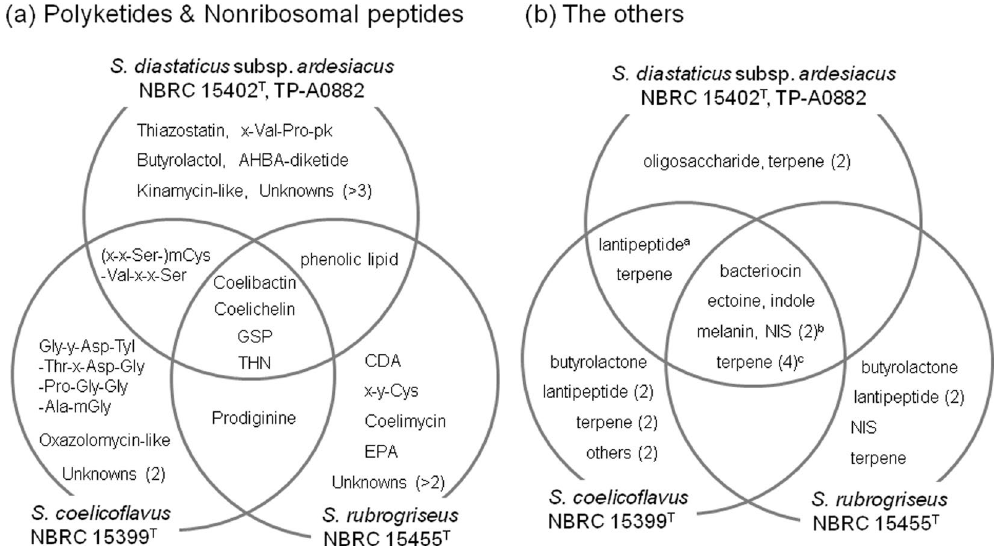
Figure 1. Schematic diagram showing diversity of NRPS & PKS gene clusters ( a ) and the other biosynthetic gene clusters ( b ) in the taxonomically close species. As nrps-3 of the S. diastaticus subsp. ardesiacus strains and nrps-iii of S. coelicoflavus NBRC 15399 T show partial sequence similarity, the diagram shows putative sharing between these two species. However, the gene products of nrps-3 and nrps-iii are divergent (mCys-Val-x-x-Ser and x-x-Ser- mCys-Val-x-x-Ser, respectively). Abbreviations: CDA, calcium-dependent antibiotic; EPA, eicosapentaenoic acid; GPS, gray spore pigment; m, methyl-; NIS, NRPS-independent siderophore; pk, moiety derived from PKS pathway; THN, tetrahydroxynaphthalene; x, unidentified amino-acid; y, unknown building block. a The lantipeptide BGC, whose precursors peptide sequences are AVLINLDhbDDGCGDhaDhbCDhaDhaPCADhbNVA and CNGDhaCADhbNVA, is not present in the genome of of S. diastaticus subsp. ardesiacus NBRC 15402 T ; b including desferrioxamine; c albaflavenone, hopene, carotenoid &